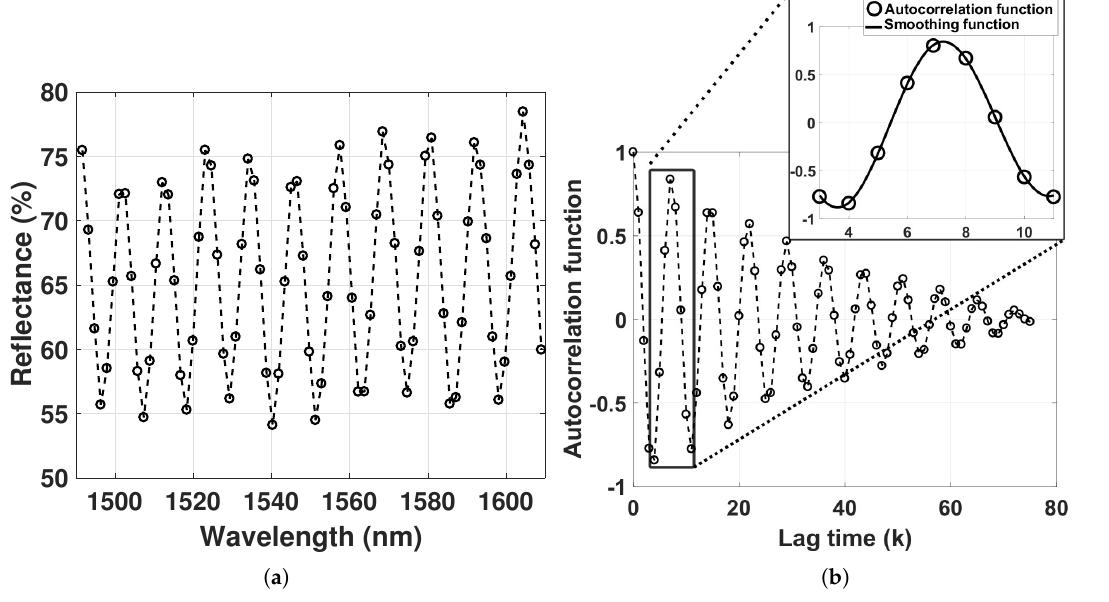
Figure 4. ( a ) Reflectance in the λ I range from the hydrogel with GNRs in pH of 4.5; ( b ) autocorrelation function of the interferometric